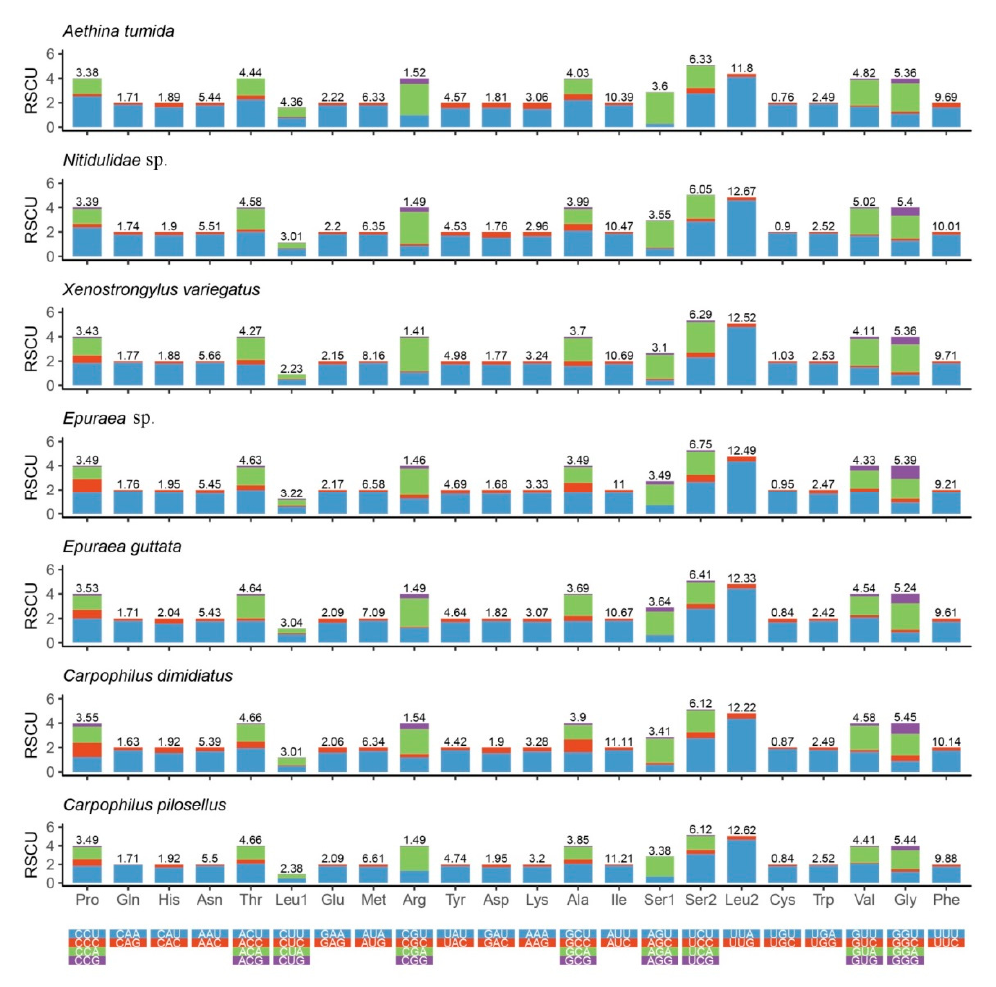
Figure 3. Relative synonymous codon usage (RSCU) of the mitochondrial DNA protein-coding genes (PCGs) of seven nitidulid species.